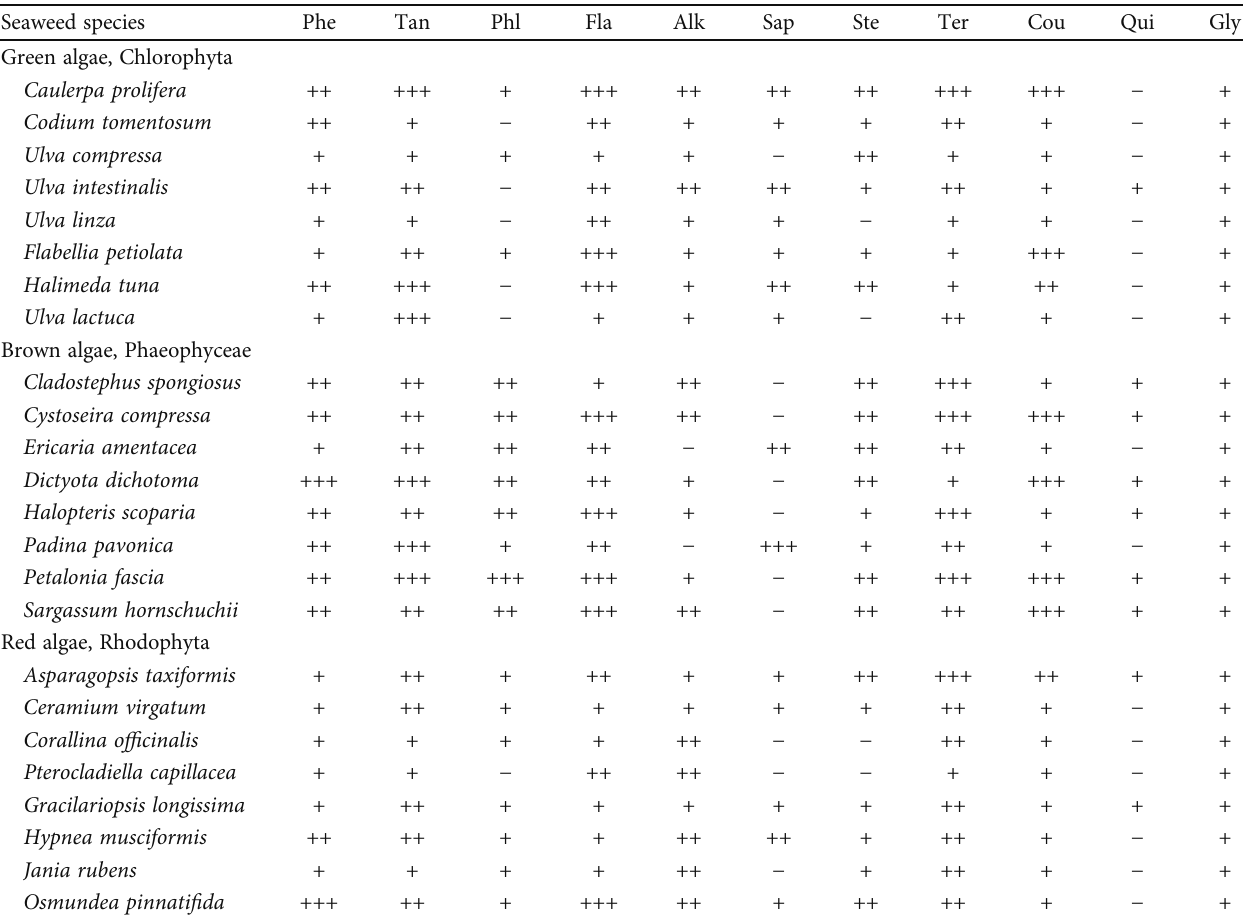
Table 1: Qualitative phytochemical analysis of crude extracts of green, brown, and red algae. Seaweed species